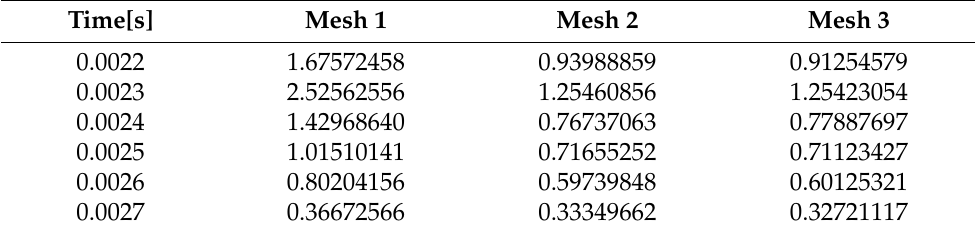
Table 11. Release of neurotransmitter during exocytosis phase for three different meshes of the real bouton model [vesicles/time step]. Mesh 1—the worst mesh, Mesh 2—Mesh 1 improved with TetGen, Mesh 3—Mesh 2 improved with